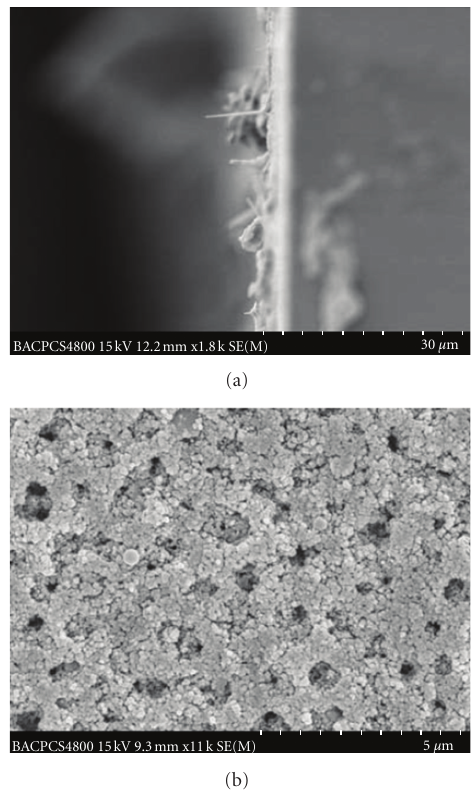
Figure 3: SEM cross-sectional (a) and top-view image (b) of ZnO tetrapods/TiO 2 photoanode fabricated via screen printing.